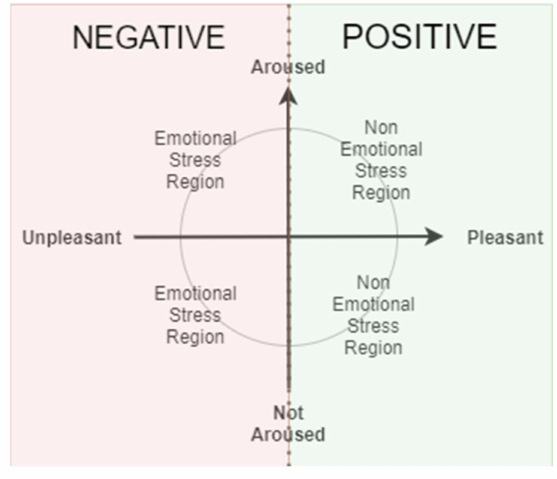
Figure 7. Pos/Neg as a model that identifies between good (no stress) and bad (stress)